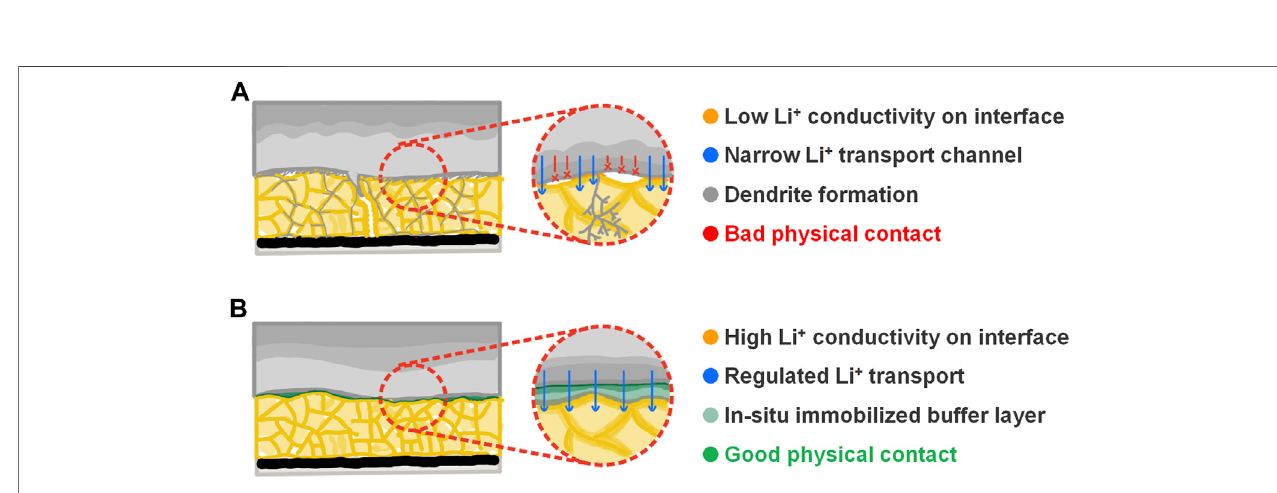
FIGURE 6 | (A) Schematic illustrating the bad interface contact between lithium metal anode and the Li interface contact between lithium metal anode and the Li 2 OHCl SSE pellet by the in situ solidi fi cation reaction of the liquid electrolyte.